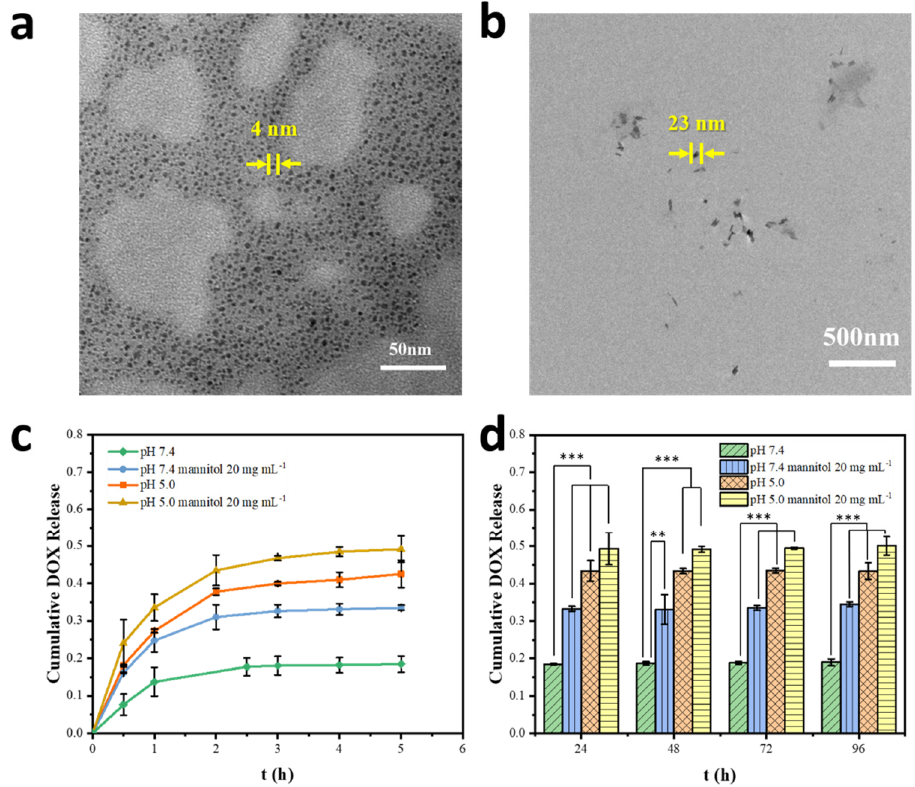
Figure 5. Dually responsive DOX release in vitro. ( a , b ) TEM images of DOX-loaded Hep/PQCS-PVA NPs in DMEM solutions at pH 5.0 and in the presence of mannitol (20 mg mL − 1 ). ( c , d ) Cumulative release of DOX from the DOX-loaded Hep/PQCS-PVA NPs with or without treatment with 20 mg mL − 1 mannitol at pH 7.4 or pH 5.0. **: p < 0.01, ***: p < 0.001.